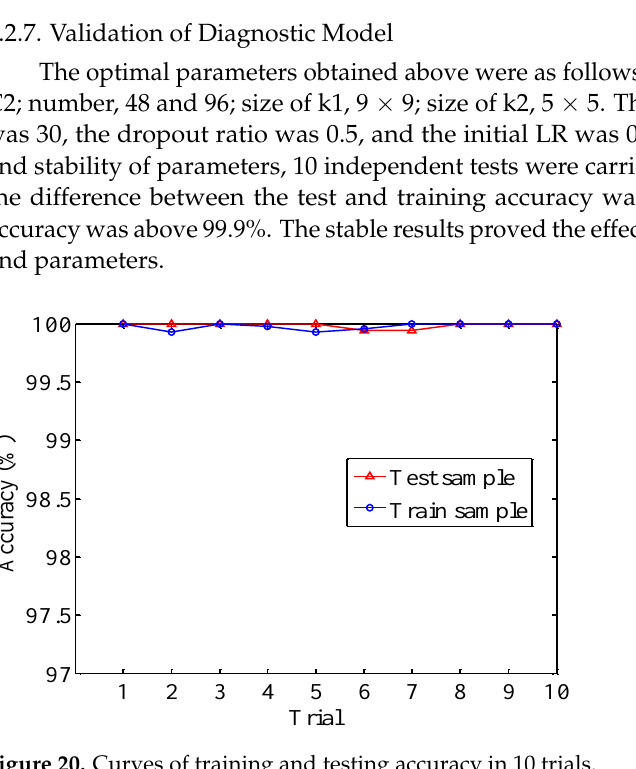
Dimensionality reduction was achieved using t-stochastic neighbor embedding ( t